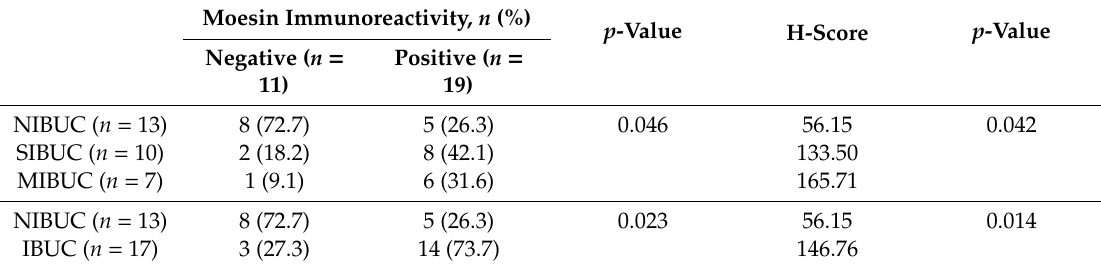
Table 1. Correlation between moesin immunocytochemistry (ICC) and invasion depth of bladder urothelial carcinoma